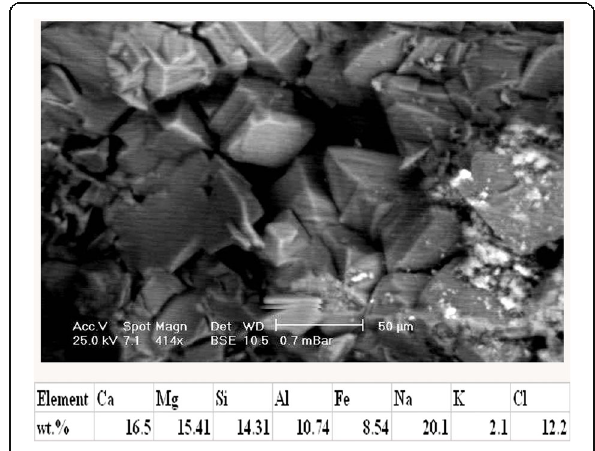
Fig. 3 BSE image and EDX analysis data showing the dolomite crystals is up to 80 μ m and patches of halite